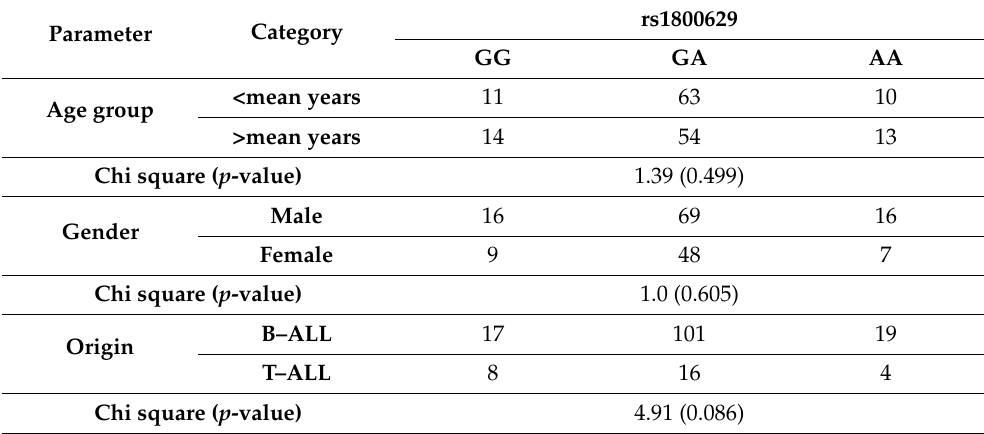
Table 4. Distribution of rs1800629 among patients according to age group, gender and origin of